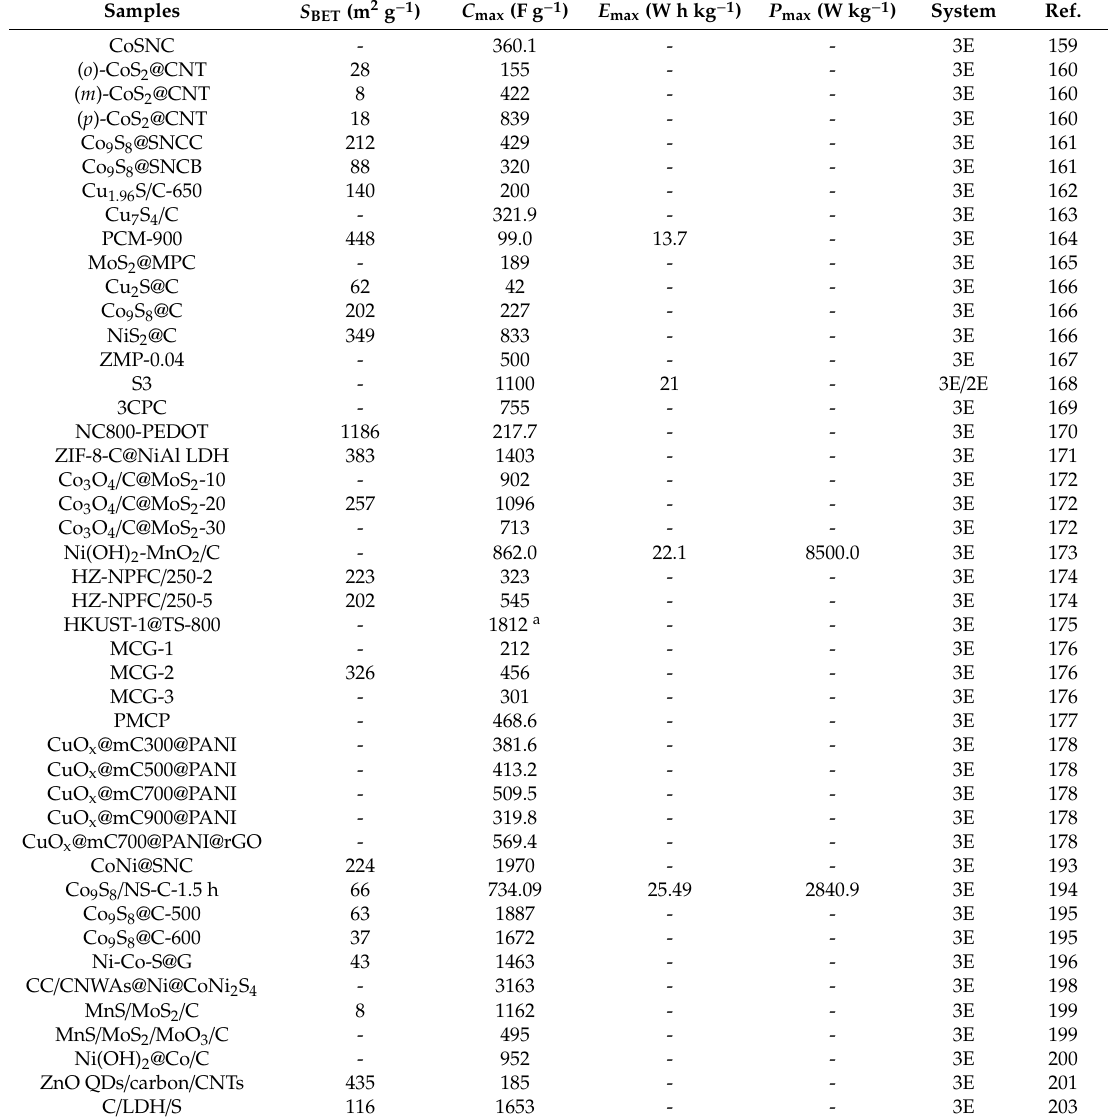
Table 10. The electrochemical capacitive properties of other types of composites.